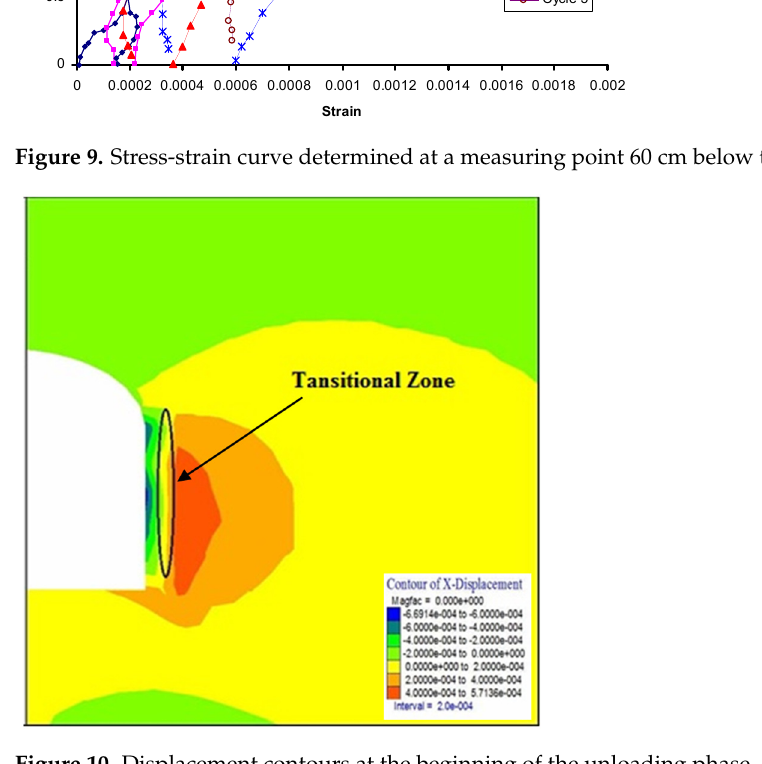
Figure 10. Displacement contours at the beginning of the unloading phase.